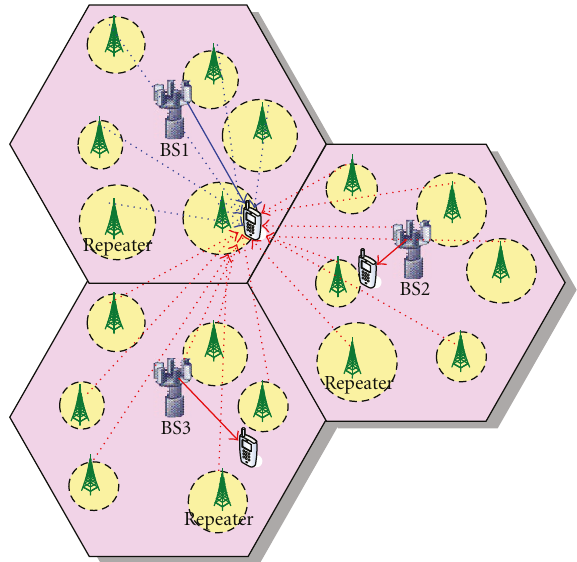
Figure 2: Co-channel interference from an optical repeater from neighboring